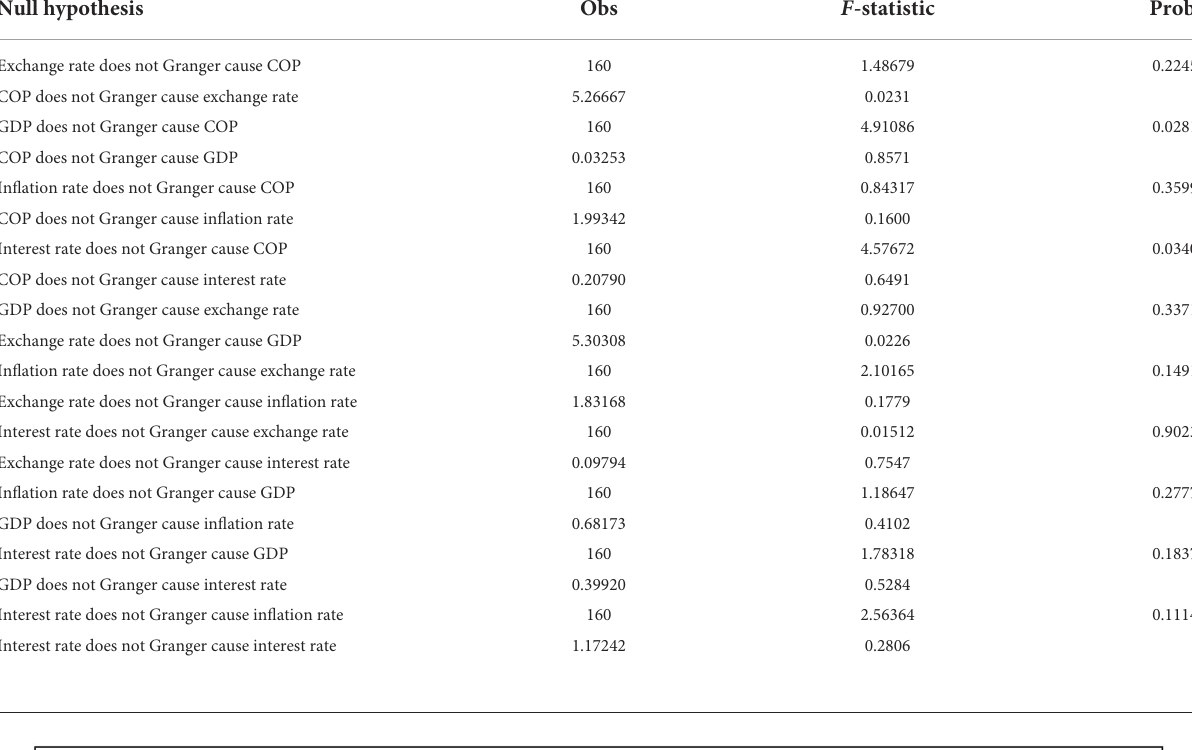
TABLE 3 Pairwise Granger causality test.